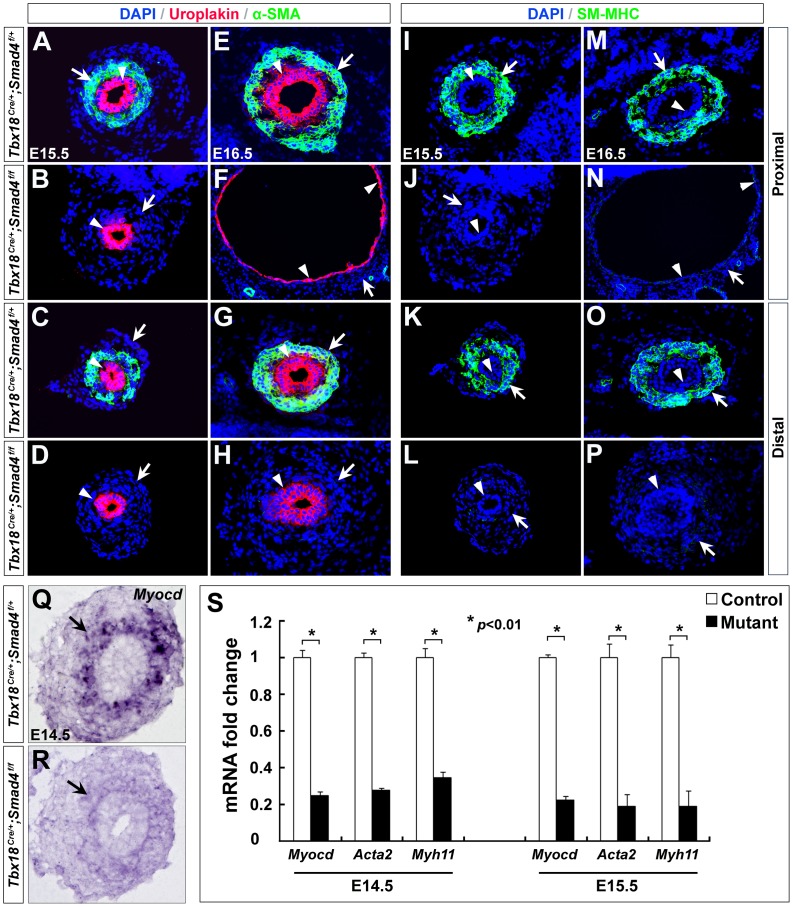
SMC differentiation is perturbed in Smad4CKO ureters.(A-H) Immunostaining of α-SMA and Uroplakin in the control (A/C/E/G) and mutant ureters (B/D/F/H) at E15.5 and E16.5. Arrowheads indicate Uroplakin (urothelium) and arrows indicate α-SMA staining (SMCs). (I-P) Immunostaining of SM-MHC in the control (I/K/M/O) and mutant embryos (J/L/N/P) at E15.5 and E16.5. Arrowheads indicate urothelium and arrows indicate SMCs. (Q,R) RNA in situ hybridization revealed Myocd expression is downregulated in the mutants (arrows) at E14.5. (S) Relative expression of Myocd, Acta2 and Myh11 was determined by qRT-PCR in the mutant and control littermate ureters at E14.5 and E15.5.